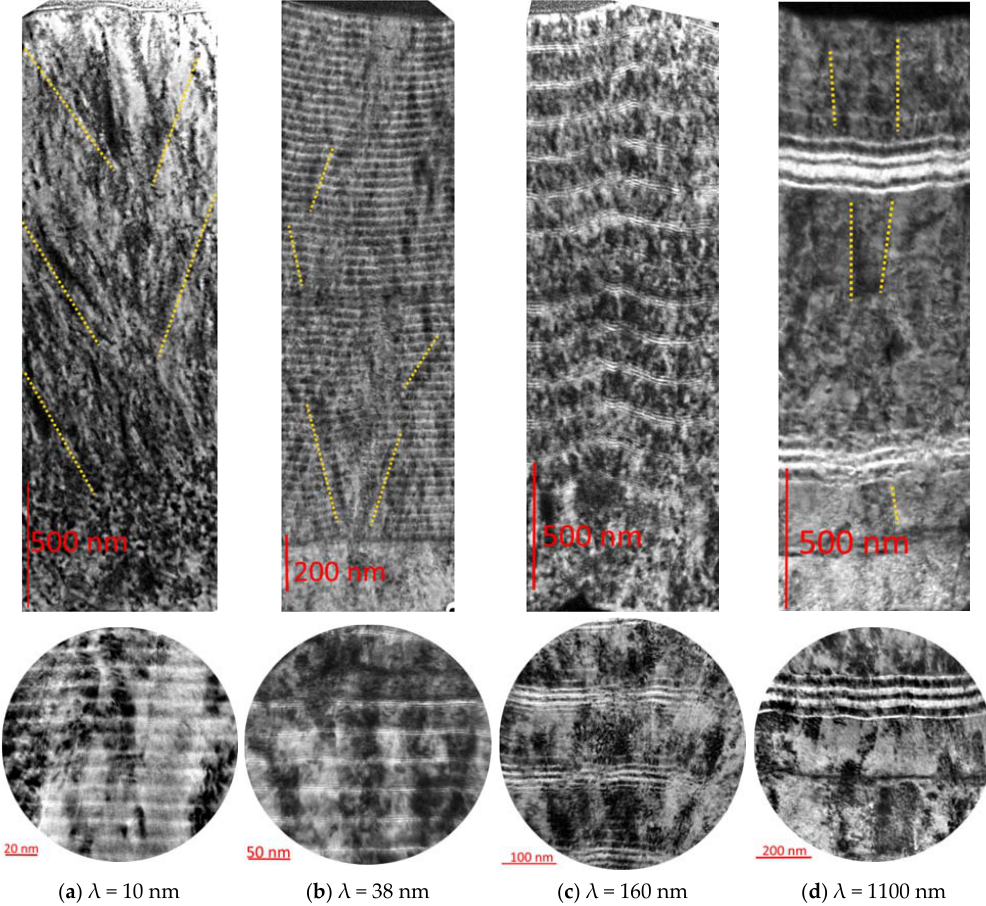
Figure 8. Formation of the cluster structure of the Ti–TiN–(Ti,Cr,Al)N coatings depending on the nanolayer period λ . ( a ) λ = 10 nm; ( b ) λ = 38 nm; ( c ) λ = 160 nm; ( d ) λ = 1100 nm.